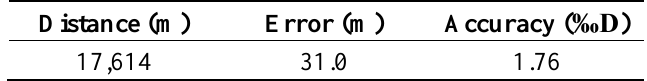
Table 6. On-line experimental results in Experiment